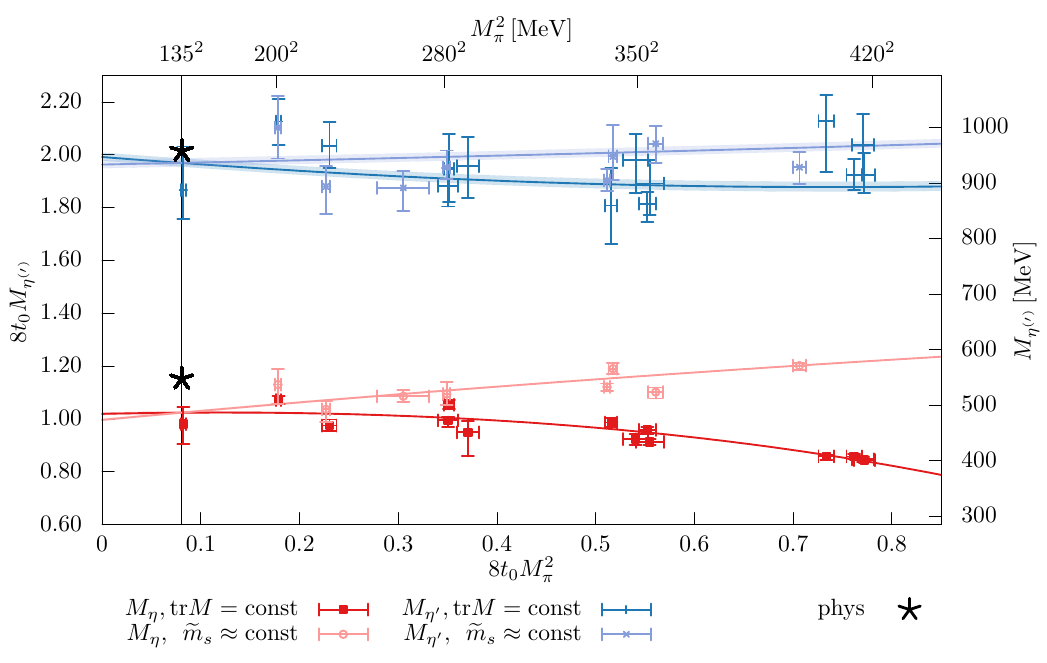
Figure 17. LO parametrization of the masses of the η and the η 0 mesons for our two trajectories in the quark mass plane. The data are corrected for lattice spacing effects according to the